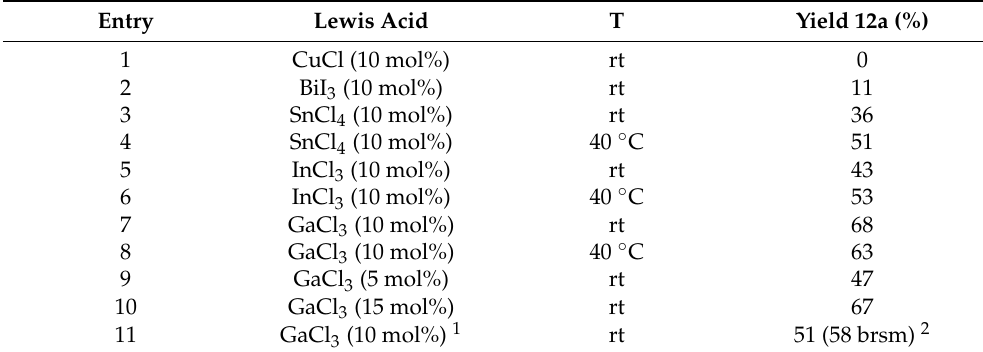
Table 2. Optimization of 12a formation.